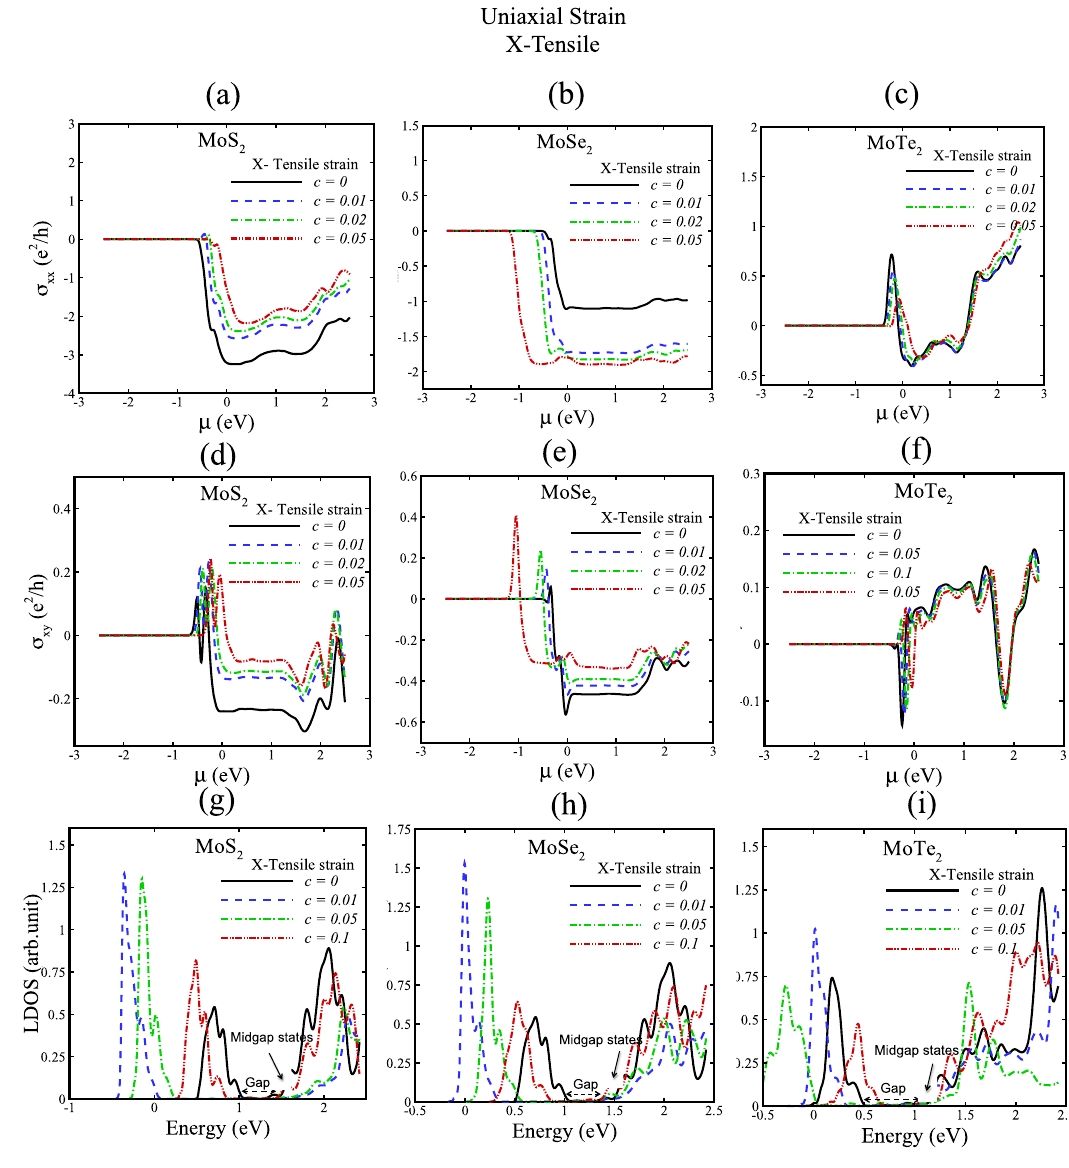
Figure 5. Hall conductivity and local density of states (LDOS) of MoX 2 (X = S, Se, Te) for uniaxial X-tensile strain with c = 0, 0.01, 0.02, 0.05, 0.1. In ( g ), ( h ) and ( i ) gap and midgap states are